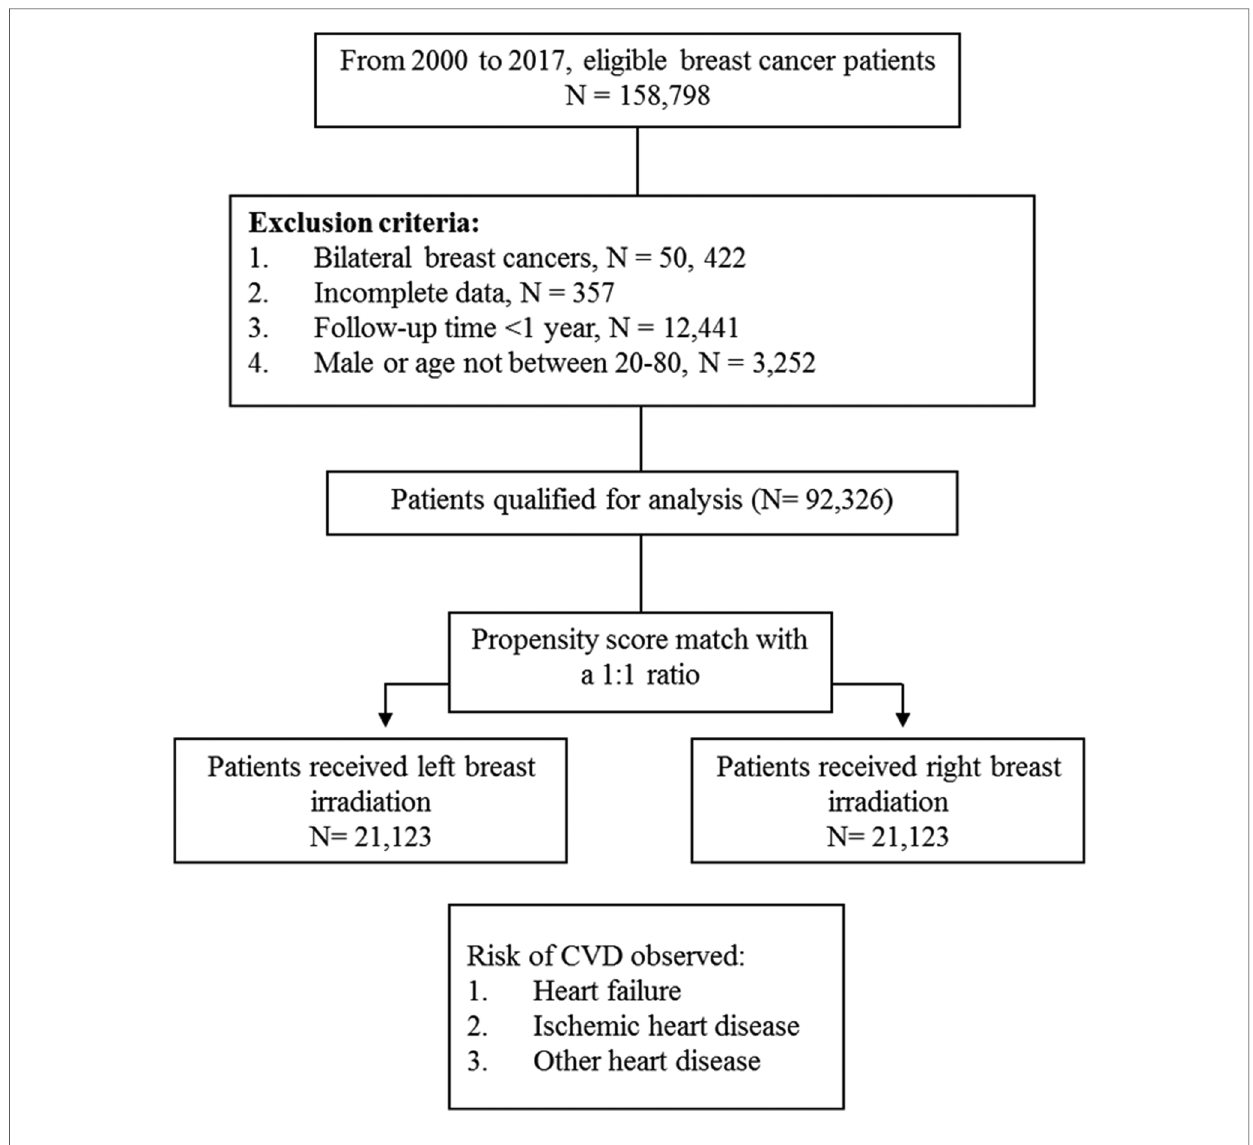
FIGURE 1 Patient fl ow